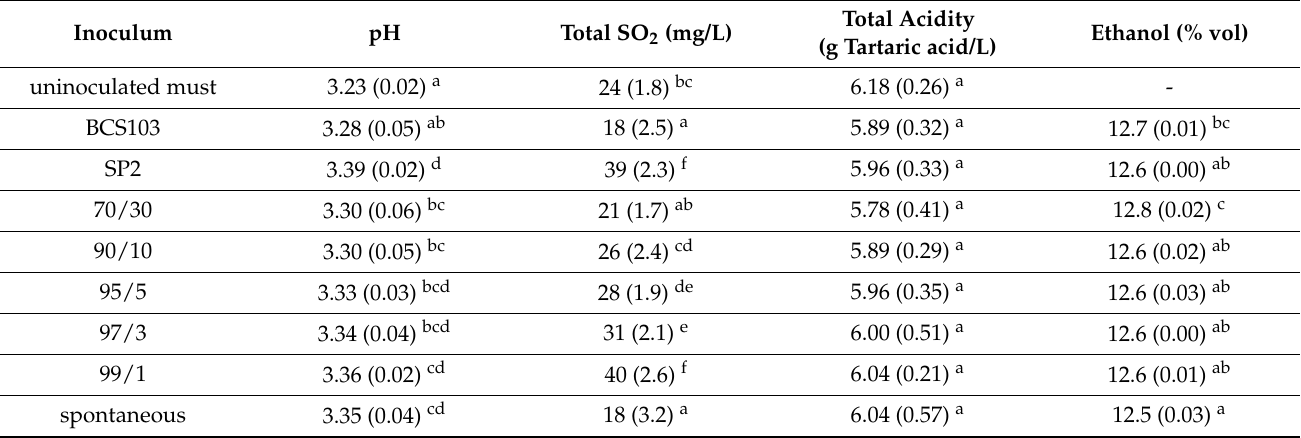
Table 3. Standard enological parameters at the beginning and the end of alcoholic fermentation of Sauvignon Blanc